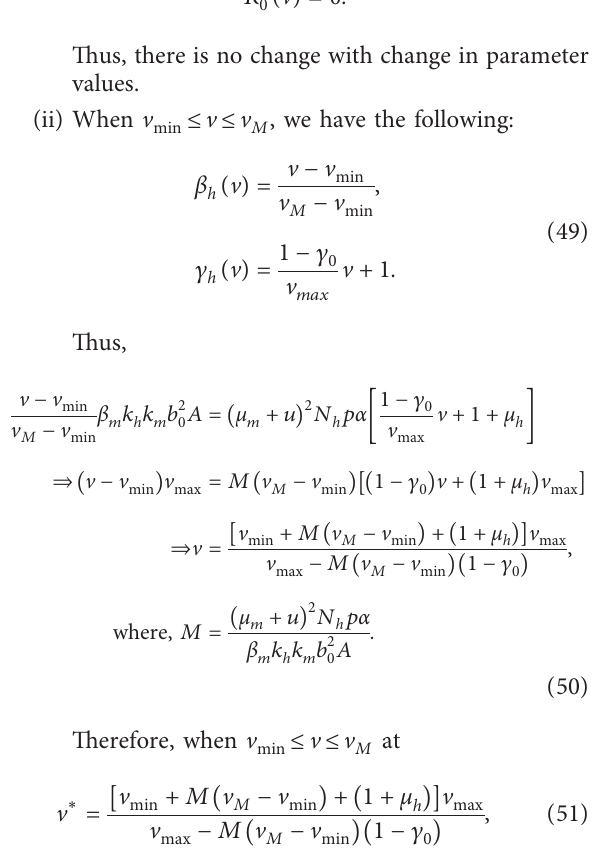
Figure 10: Biting rate with different values of r .